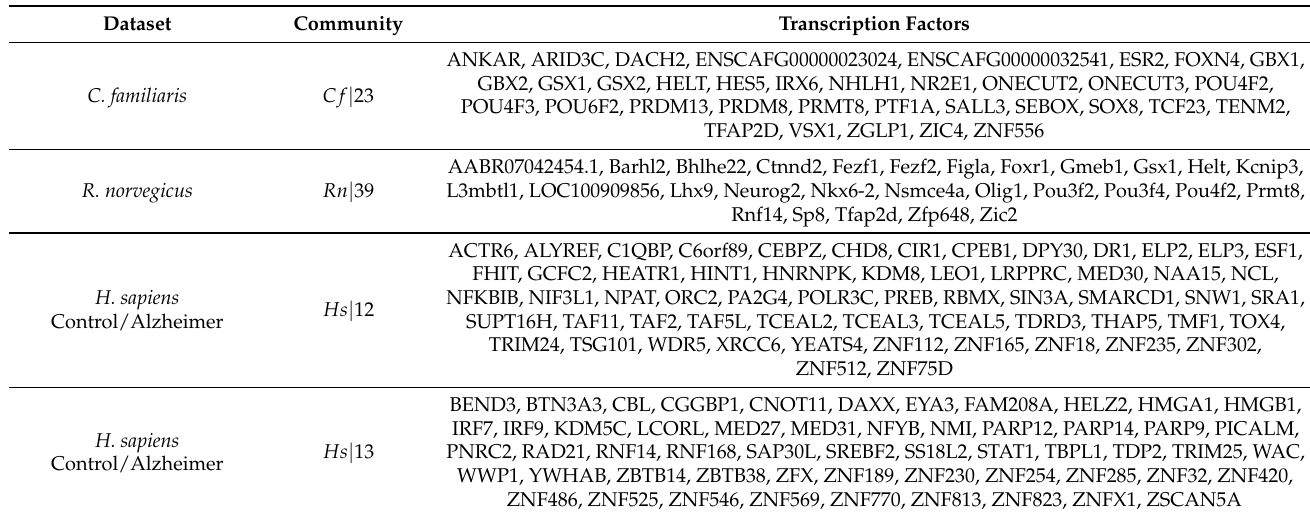
Table A1. List of TFs belonging to the communities Cf | 23, Rn | 29, Hs | 12 and Hs | 13 from the GXN•OMP model, obtained on the C. familiaris , R. norvegicus an H. sapiens Control/Alzheimer